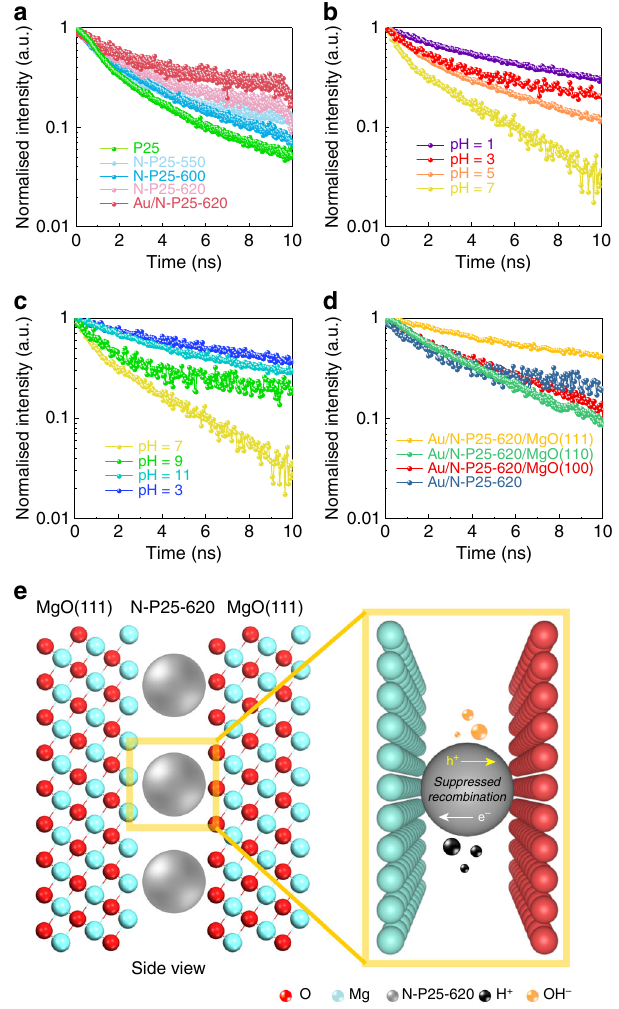
Fig. 3 Time-resolved photoluminescence (TRPL) measurements of N-doped TiO 2 photocatalysts under different conditions. a N-doped P25 treated by ammonia at different temperatures and promoted by Au. b N-P25-620 after being soaked in acidic solutions with different pH. c N-P25-620 after being soaked in alkaline solutions with different pH. d Au/N-P25-620/MgO(111), Au/N-P25-620/MgO(110) and Au/N-P25-620/MgO(100) with Au/N-P25- 620 included as a reference (exciton lifetimes and errors are shown in Supplementary Table 4). e Schematic illustration of the local electric fi eld of polar MgO(111) nanocrystals with negative and positive ion-terminated surfaces can assist the photocatalytic water splitting to H 2 /O 2 via H + and OH − surrounding the N-doped TiO 2 catalyst